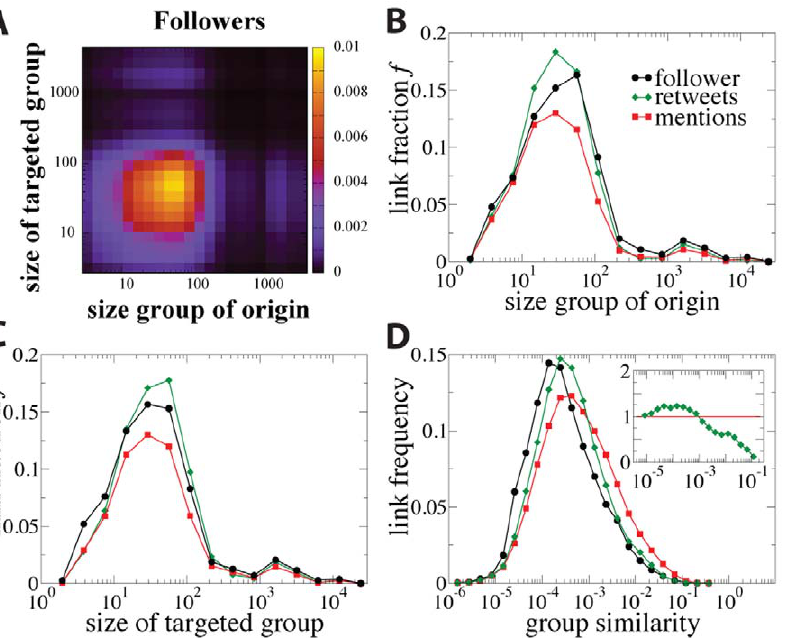
Figure 4. Group-group activity. (A) Distribution of the number of links in the follower network between groups as a function of the size of the groups. (B) Fractions f of links of the different types (follower, with mentions and with retweets) as a function of the size of the group at the link origin, and (C) at the targeted group. (D) Frequency of between-group links as a function of the group-group similarity for the different type of links. In the inset, ratio between the frequency of links with retweets and with mentions.